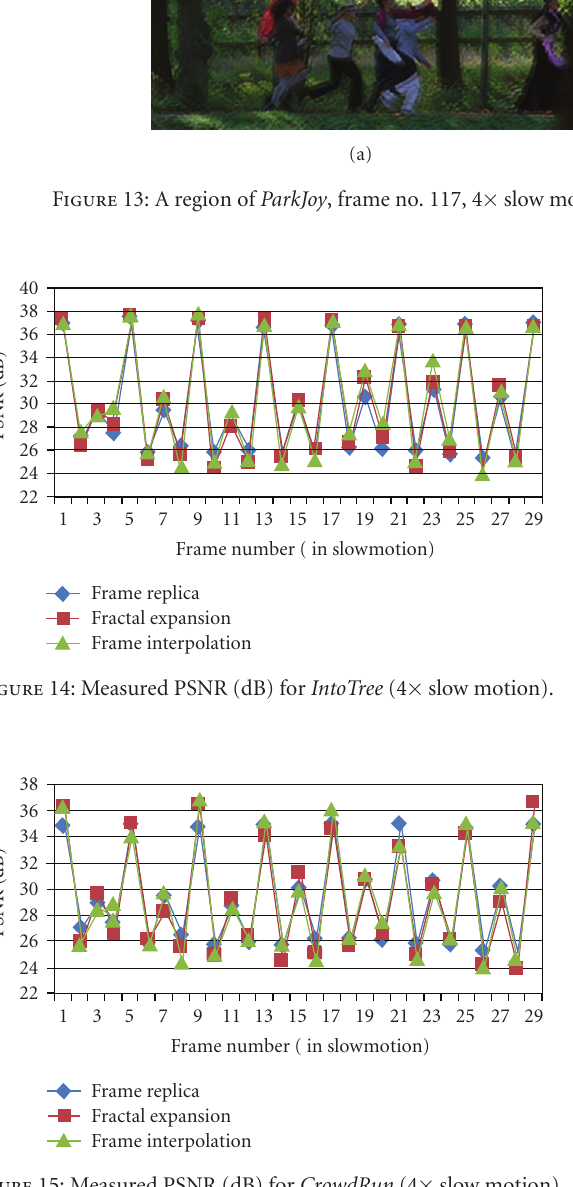
Figure 15: Measured PSNR (dB) for CrowdRun (4 × slow